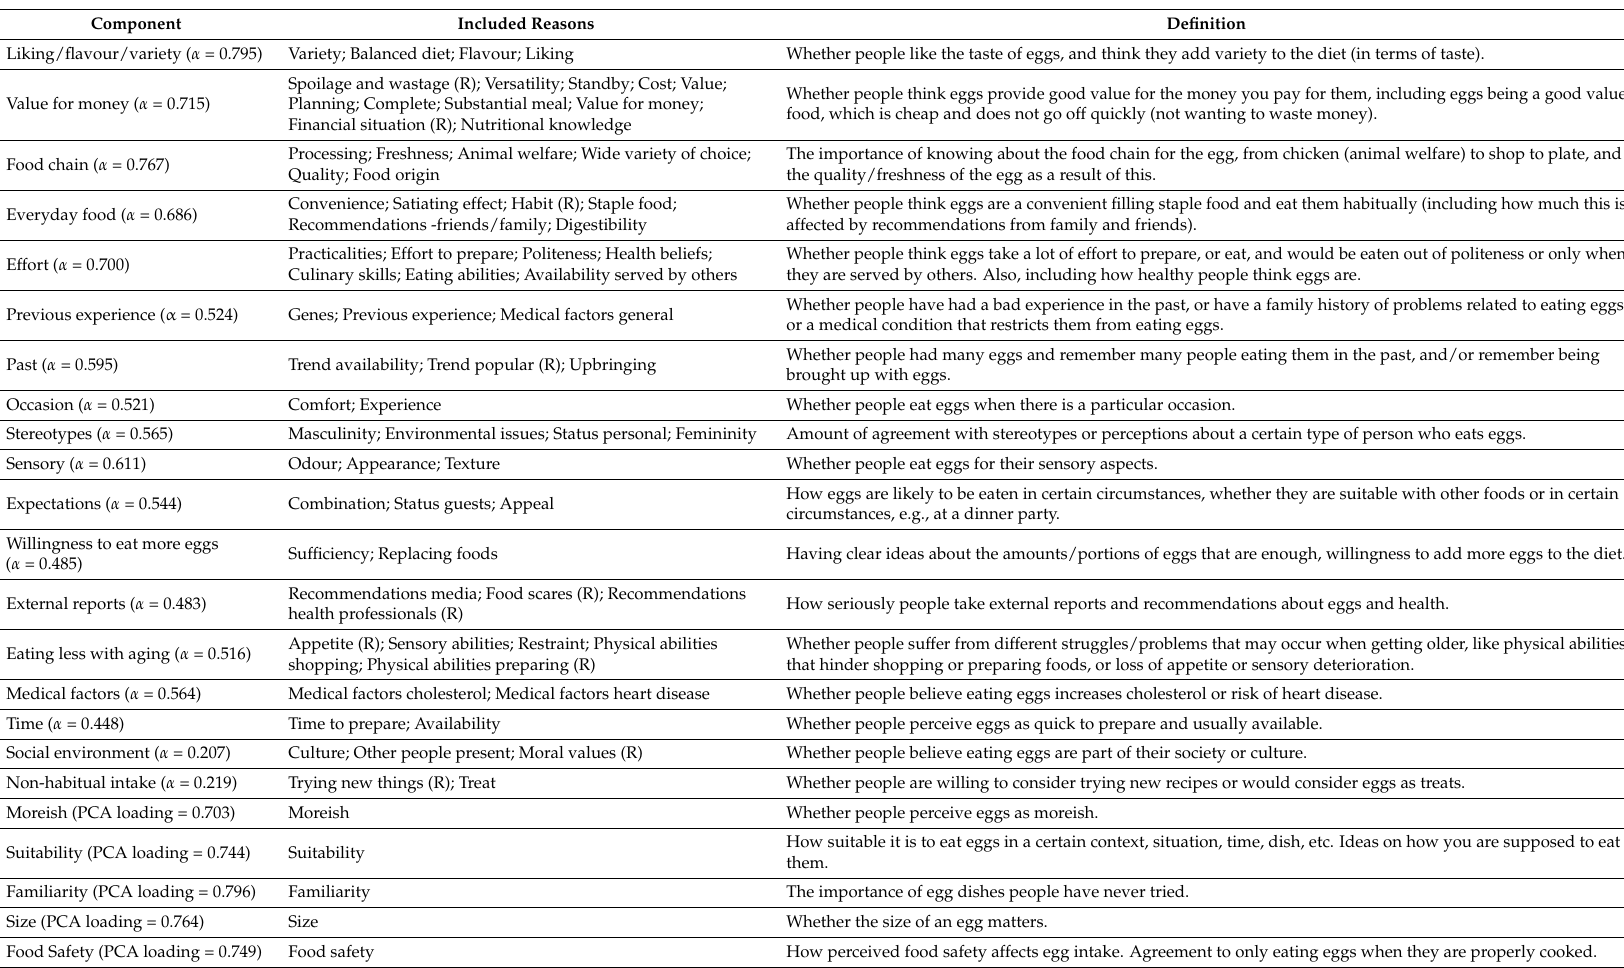
Table 2. Principal Component Analysis: Component definition and contributing